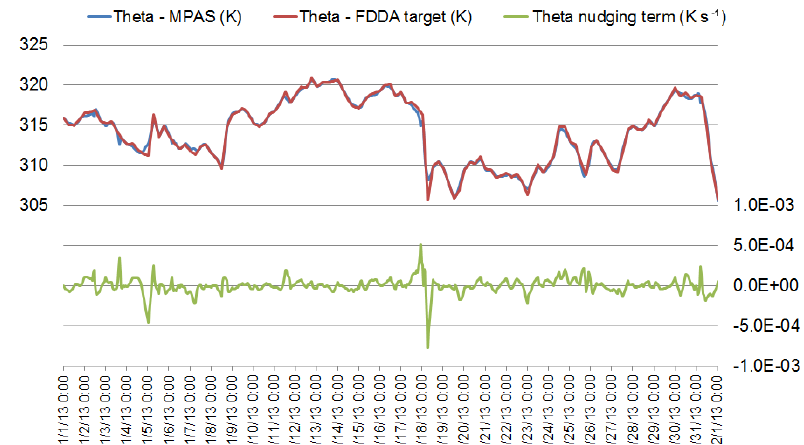
Figure 4. Timeline analysis for January 2013 showing simulated potential temperature (blue line), the potential temperature target value (red line), and the nudging term arising from their discrepancy (green line) for layer 28 of the MPAS cell containing Research Triangle Park, NC